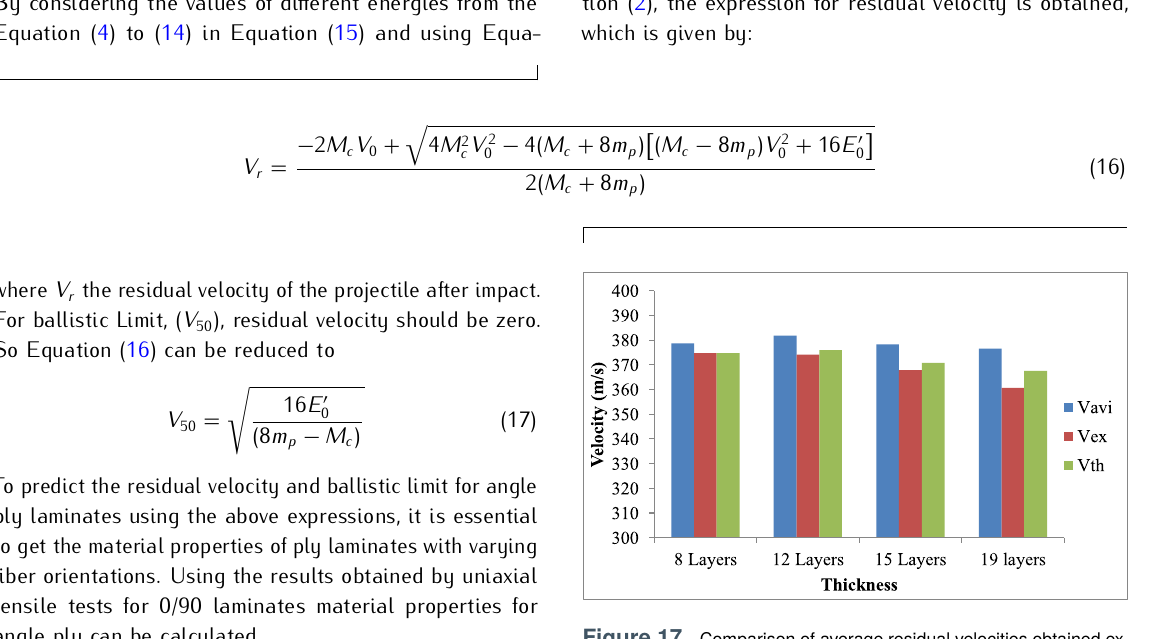
Figure 17. Comparison of average residual velocities obtained ex- perimentally and average velocity calculated analytically with initial velocity for (0/90) lay-ups.